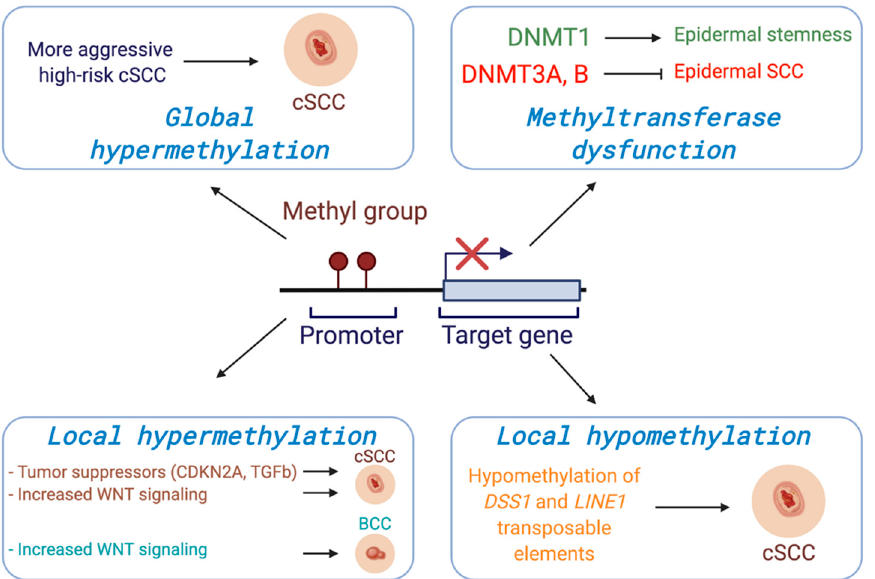
Figure 1. DNA methylation at gene promoters generally serves to suppress expression. Alterations in DNA methylation can occur both globally across the genome or more locally at specific loci in cancer and can drive tumorigenesis through transcriptional dysregulation. Consistent with a key role for DNA methylation in KCs, in vivo models have shown that DNA methyltransferases are critical regulators in the balance between epidermal differentiation and tumorigenesis.